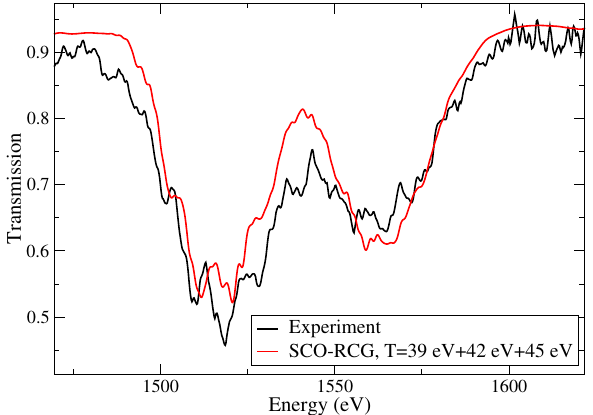
Figure 3. Bromine 2 p − 3 d absorption structures of an NaBr plasma measured by Bailey et al. [31,32]. Comparison between experiment and our SCO-RCG calculations at n e = 3 × 10 21 cm 3 , averaged over three temperatures: T = 39, 42 and 45 eV. The areal densities obtained from the He γ and He δ Na line fits are respectively 1.0 × 10 17 and 1.8 × 10 17 atoms/cm 2